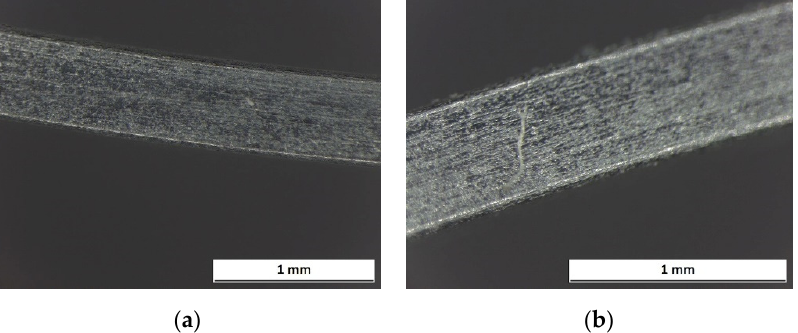
Figure 16. Tanzo archwire (American Orthodontics) in top view: ( a ) before the test; ( b ) after the test.